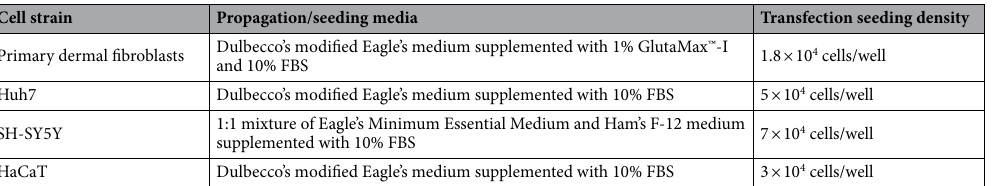
Table 4. Culture conditions for cell strains used in the study. All cells were maintained at 37 °C in a 5% CO 2 atmosphere. Cells were seeded 24 h before transfection in a 24-well plate. Fetal bovine serum (FBS) (Scientifix, Cheltenham,